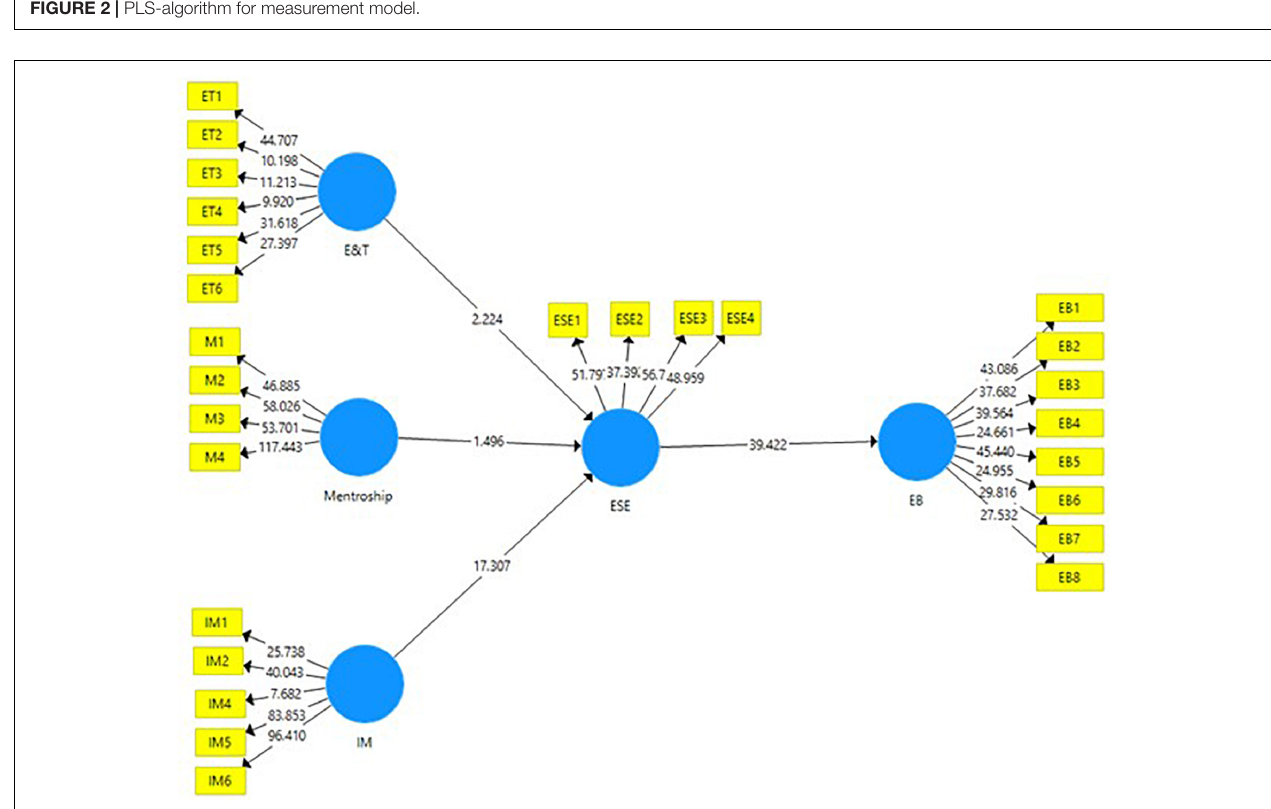
FIGURE 3 | PLS-bootstrapping for structural